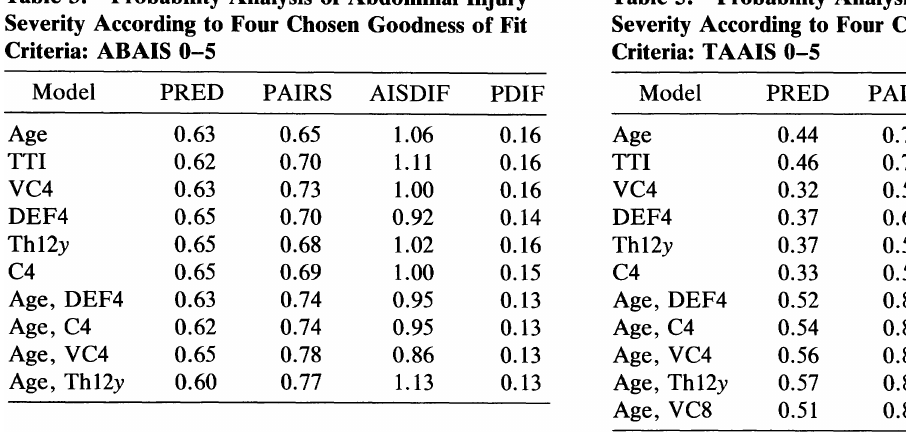
Table 3. Probability Analysis of Abdominal Injury